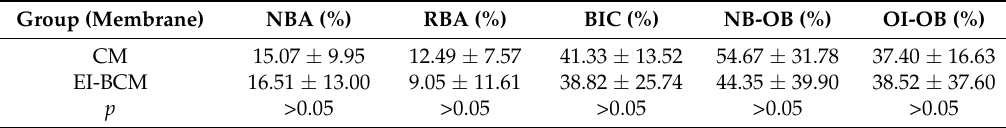
Table 2. Histometric analysis within areas of interest ( n =